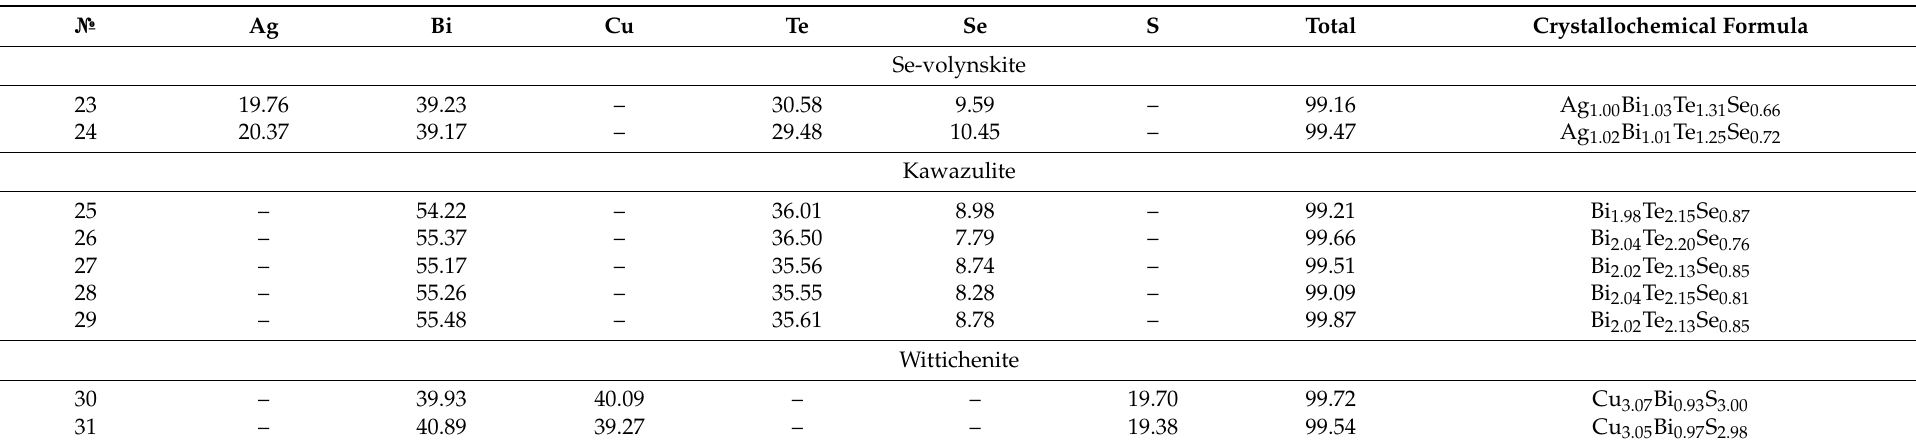
Table 2. Chemical composition of Se-volynskite, kawazulite, and wittichenite, wt